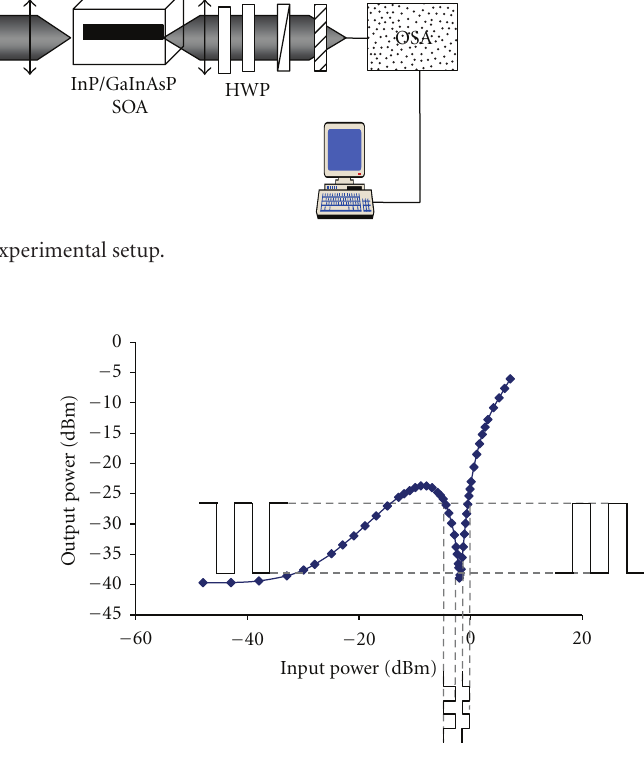
Figure 3: Measured static transfer function and principle of operation for both inverted and noninverted wavelength conversion at a blocking power equal to − 2 dBm and wavelength equal to 1550